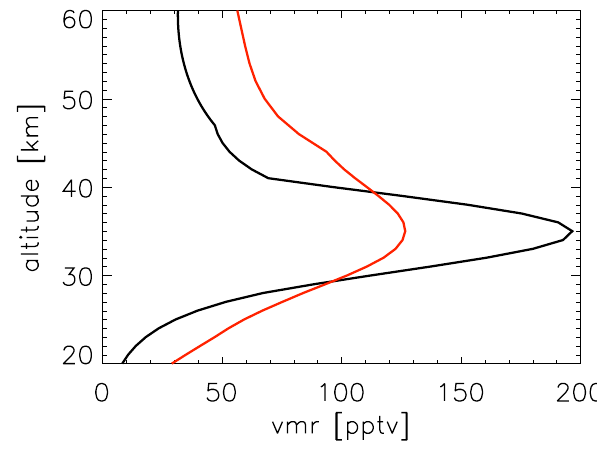
Fig. 3. Results for retrieval with synthetic spectra; black line: pro- file used to generate the synthetic measurements; red line: retrieval result.